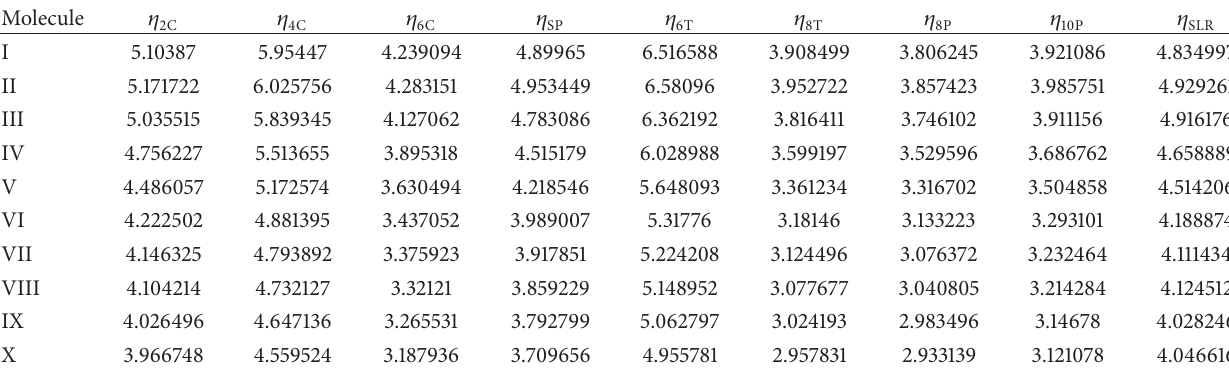
Table 5: Chemical hardness values (in eV) as computed for molecules of Table 2 with first-order LUMO(1)-HOMO(1), second-order LUMO(2)-HOMO(2), and third-order LUMO(3)-HOMO(3) gaps of (21) with parameters of Table 1.